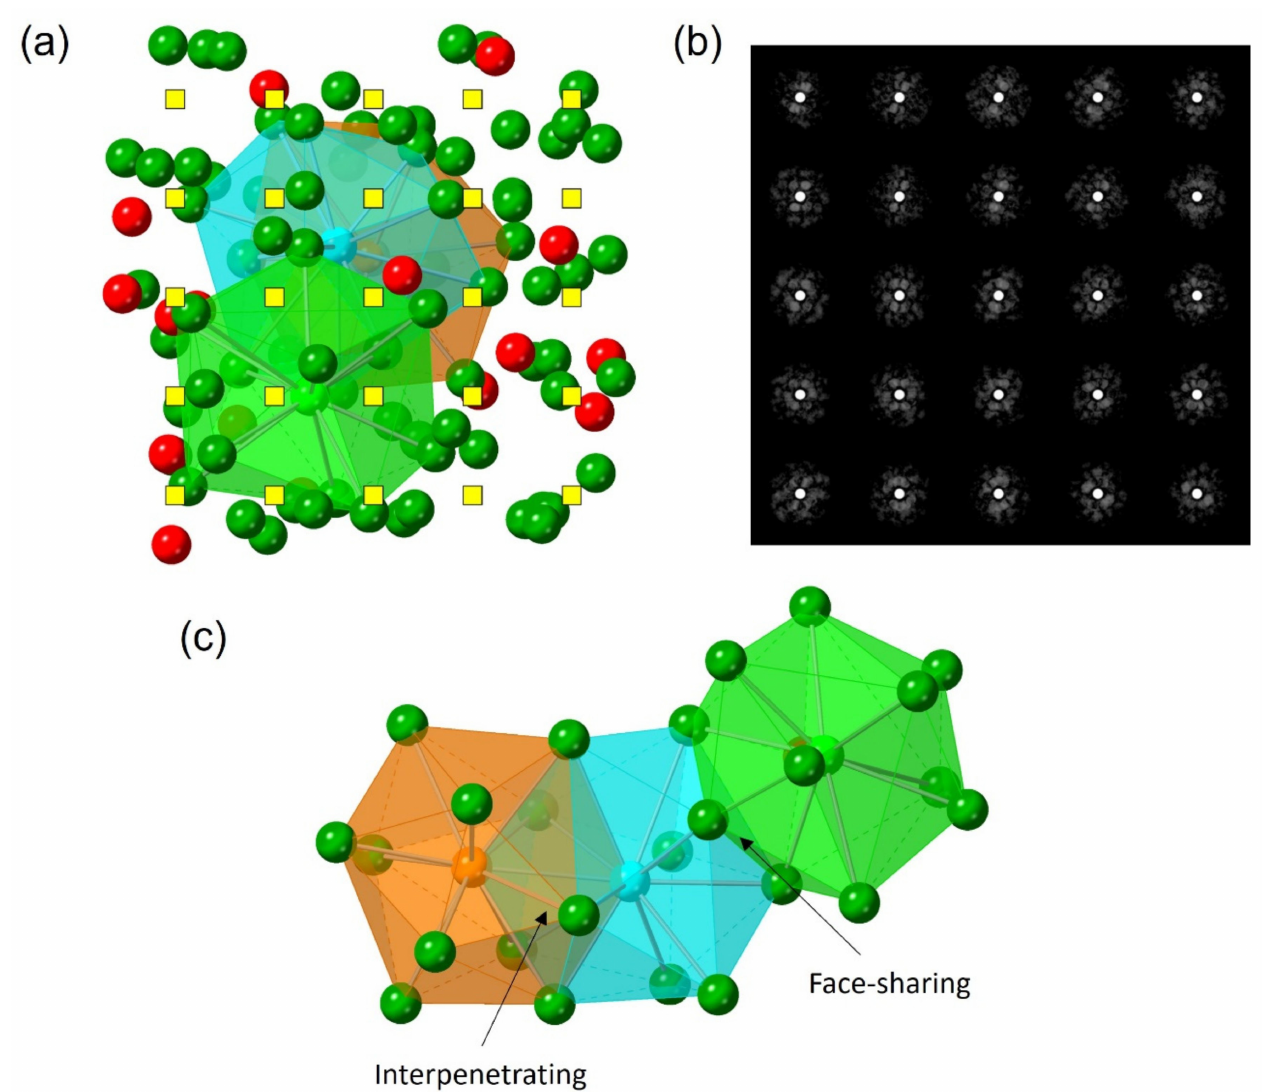
Figure 7. Analysis of the faster-cooled model (3.0 × 10 13 K s − 1 ). ( a ) Positions where the electron beam is virtually irradiated, ( b ) calculated electron diffraction patterns from the positions, and ( c ) aggregate of coordination